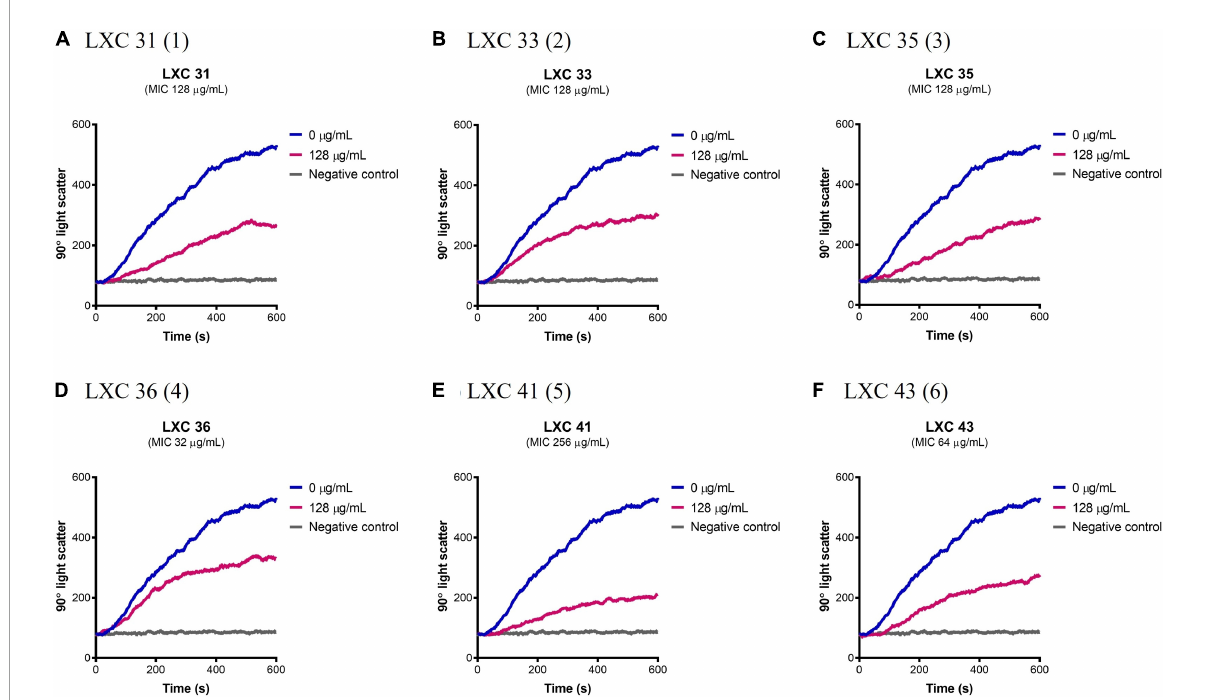
FIGURE5 The LXC compounds inhibit Ab FtsZ polymerization. (A–F) Ab FtsZ (0.15 mg/mL) was pre-incubated in polymerization buffer (25 mM PIPES pH 6.8, 50 mM KCl and 10 mM MgCl 2 ) together with the test compound at 128 µ g/mL for 300 s. Polymerization was then initiated with the addition of 1 mM GTP. The fluorescence was measured as a function of time at excitation and emission wavelengths of A 350 and A 350 nm, respectively, and a slit width of < 2 nm. The blue line in each panel indicates the addition of 2.5% (v/v) DMSO, the pink line indicates the test compound tested at 128 µ g/mL and the gray line represents the addition of 1 mM GDP (as negative control) instead of GTP.